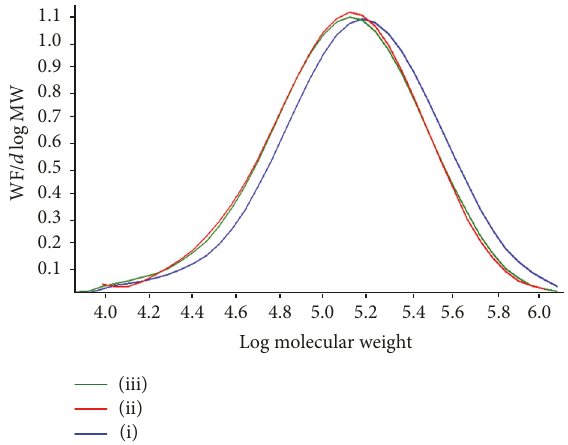
Figure 2: GPC chromatograms of neat (i), blank (ii), and grafted PLA (iii)